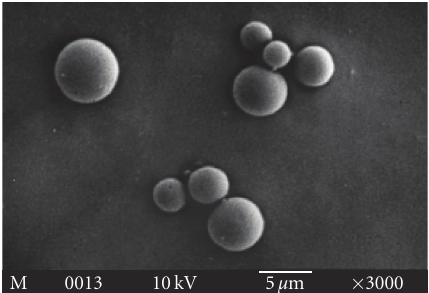
Figure 1: Scanning electron micrograph of PLGA microsphere formed by emulsion-solvent evaporation